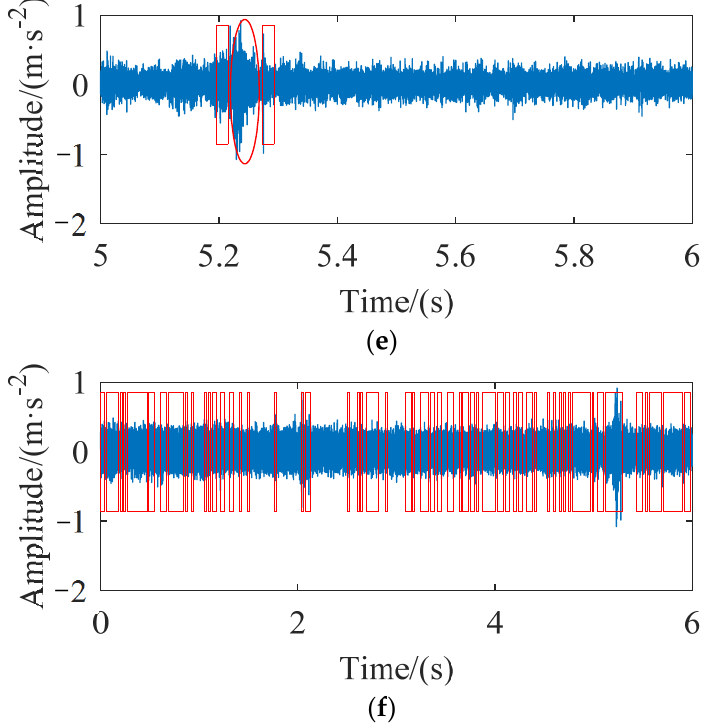
Figure 20. Detection results of random large impact data. ( a ) CF-POIF; ( b ) CF-IF; ( c ) CF-LOF; ( d ) Mahalanobis distance; ( e ) local enlarged result with Mahalanobis distance; ( f ) K-means.